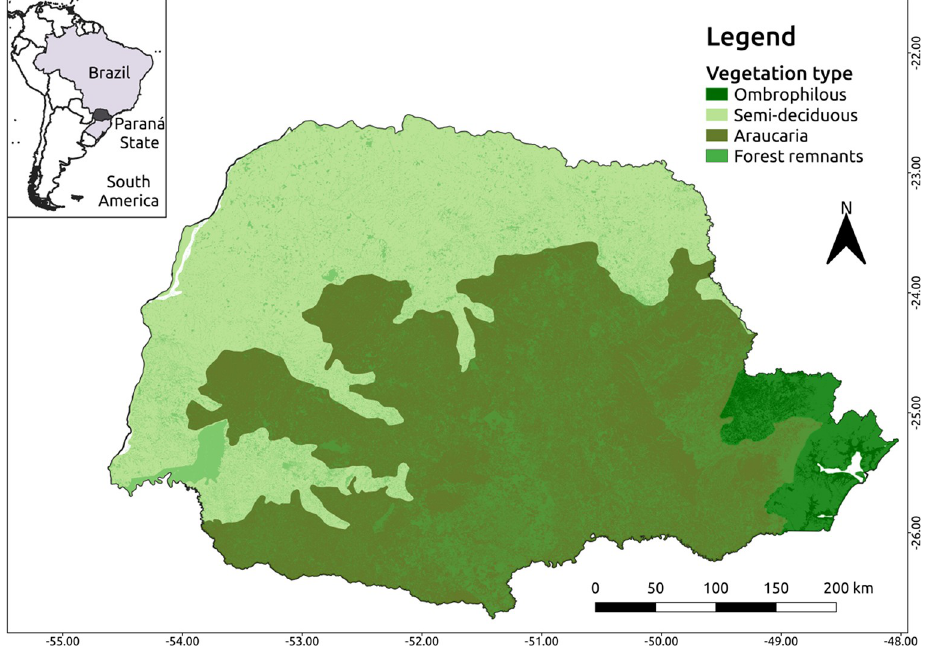
Fig 1. Geographical location, main vegetation types and forest remnants of the Atlantic Forest biome of the State of Parana´, Southern Brazil. Software: QGIS. Source: 1. IBGE (2015). Instituto Brasileiro de Geografia e Estatı´stica. Continuous cartographic bases (1:250.000). Avaliable from: ftp://geoftp.ibge.gov.br/cartas_e_mapas/bases cartograficas_continuas/bc250/versao2017/. 2. Remnants: Ribeiro, M. C. et al. ATLANTIC SPATIAL: a dataset of spatial variables from the Atlantic Forest of South America (in prep.). Author: Maurı´cio Humberto